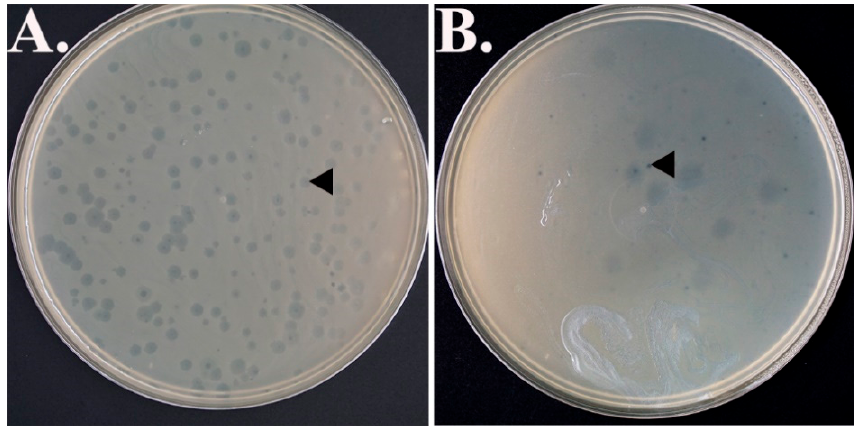
Figure 1. Plaques formation (as indicated with the black arrow heads) on ( A ) E . coli 15-318 strain, ( B ) Non-resistant E . coli strain K12.